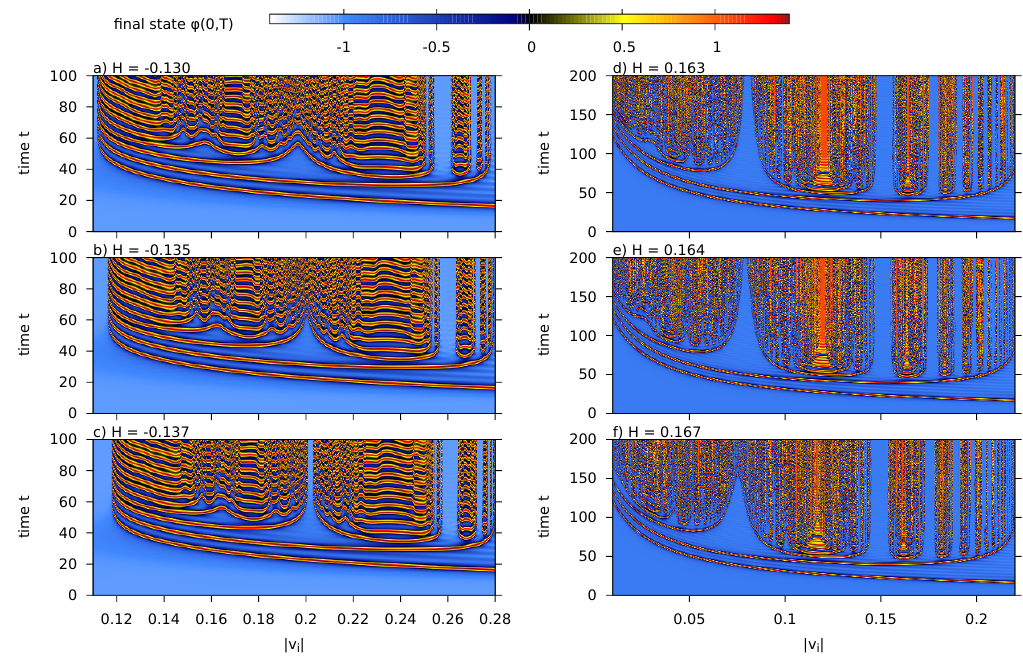
Figure 8 . Scans of (cid:30) (0 ; t ) for various values of H , showing the emergence (on the left) and destruction (on the right) of a two-bounce window as H moves away from zero.